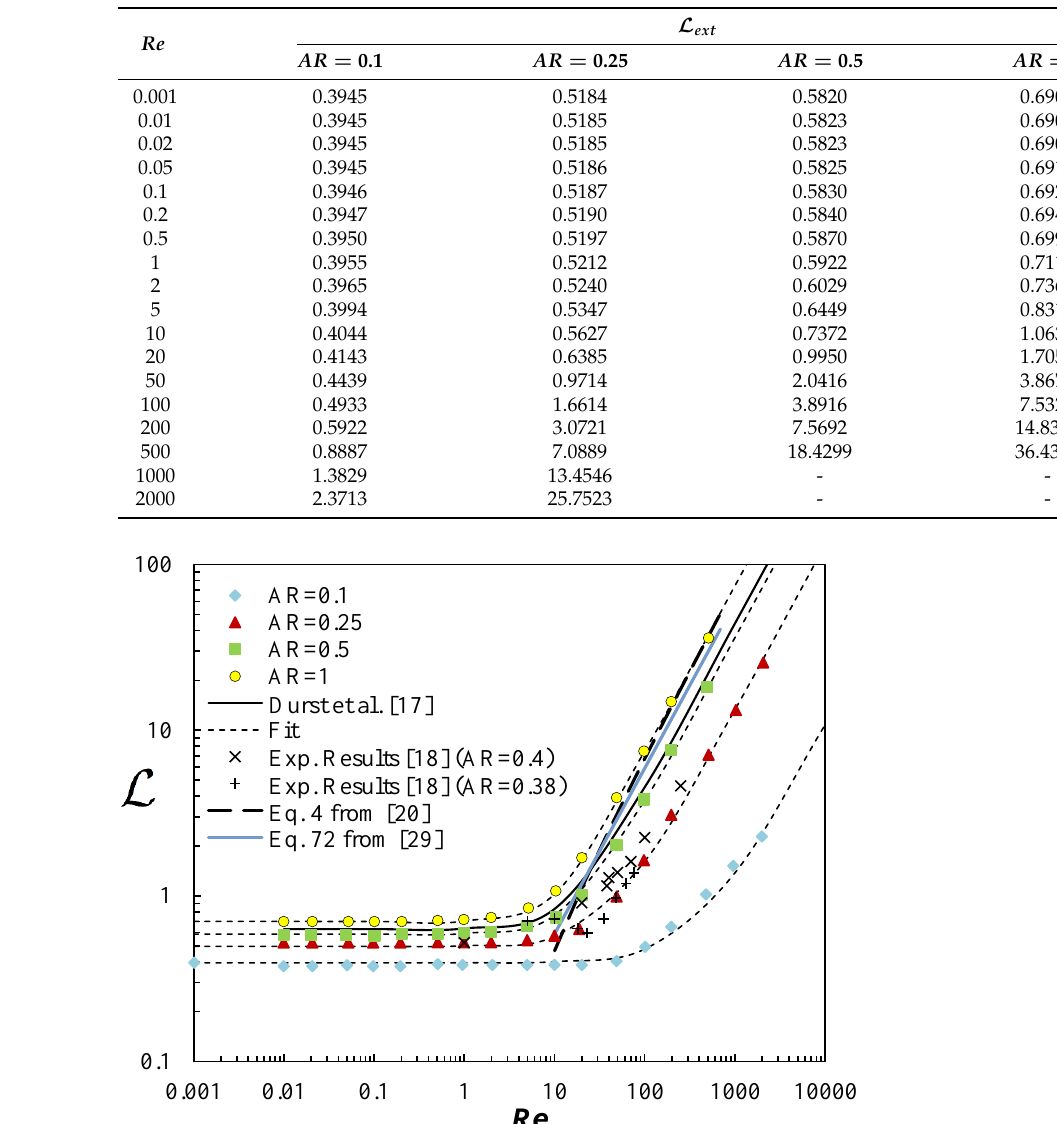
Table 3. Values of L ext for different Re and AR .